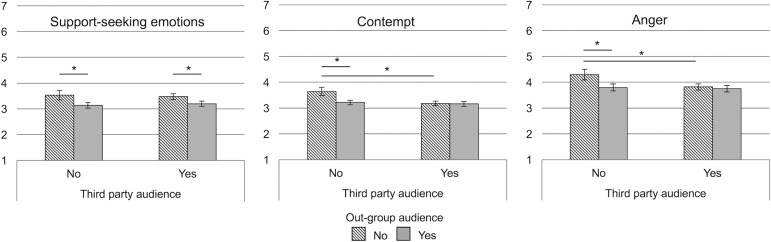
Support-seeking emotions, contempt, and, anger as experienced and expressed towards different audiences (across bogus pipeline conditions) in Study 2.Error bars depict 95% confidence intervals. *p < .05.